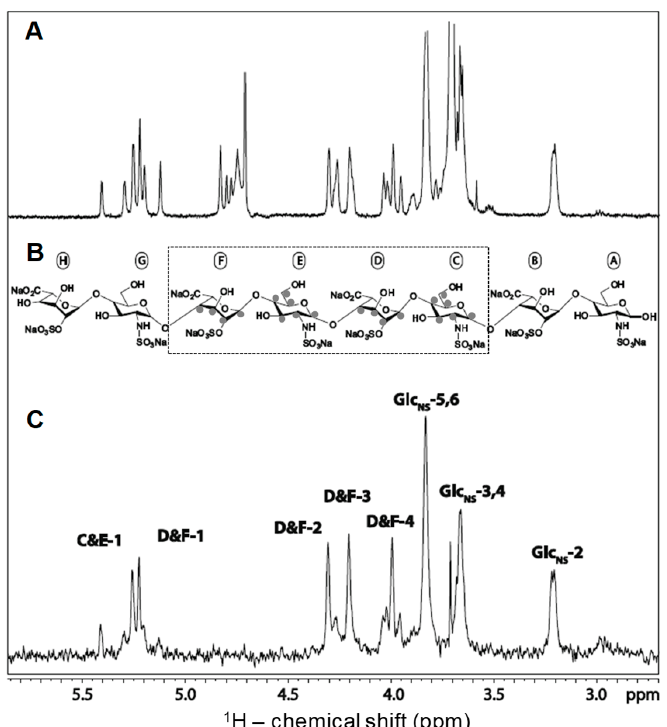
Figure 5. NMR assignments of the STD spectrum obtained from the complex of a heparin octasaccharide and fibroblast growth factor 2 (FGF2). ( A ) Reference spectrum recorded in the presence of FGF2, but without saturating the protein with magnetization; ( B ) Structure of the heparin octasaccharide utilized in the analysis. This ligand is composed of alternating IdoA2S and GlcNS units. See Table 1 for abbreviations. The internal tetrasaccharide highlighted by the dashed box indicates the binding motif recognized by the STD experiment; and, ( C ) The grey dots on the structural units indicate the signals assigned in the STD spectrum. Adapted with permission from Springer Anal. Bioanal. Chem. License in conditions provided by Springer Nature and Copyright Clearance Center, Inc. [25].